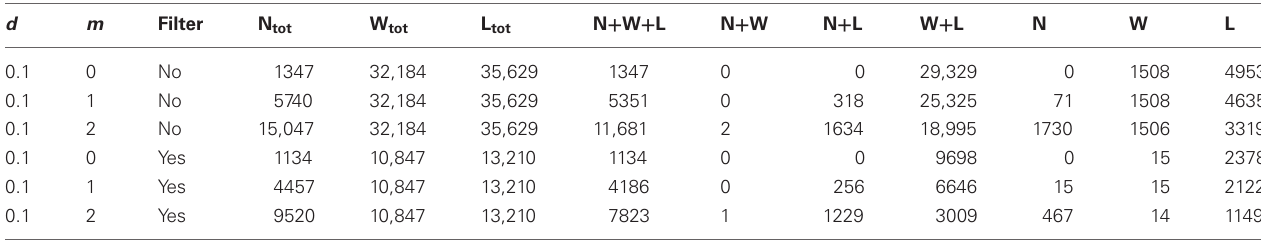
Table 1 | Number of differentially methylated sites.